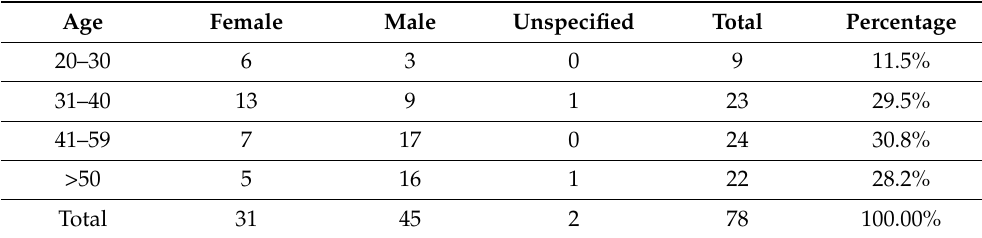
Table 1. Demographic profile of survey